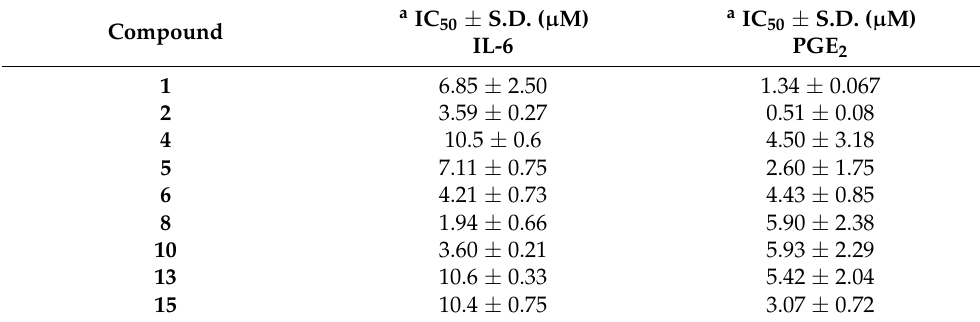
Table 1. Chemical structures and anti-inflammatory activity of the novel curcumin